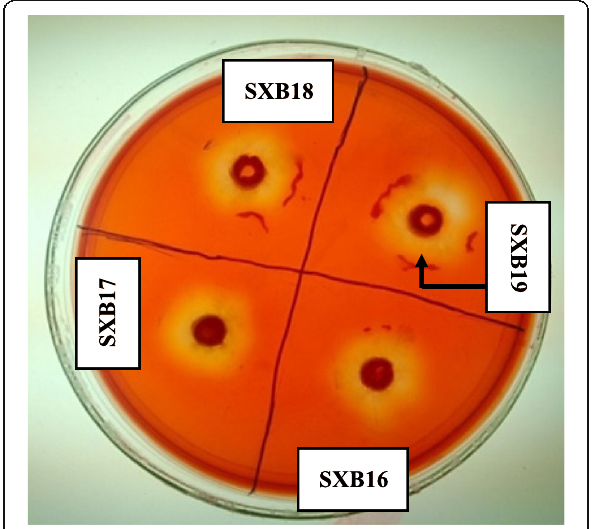
Fig. 1 Clearing zone generated by xylanolytic bacteria SXB19 in xylan agar plates after Congo red